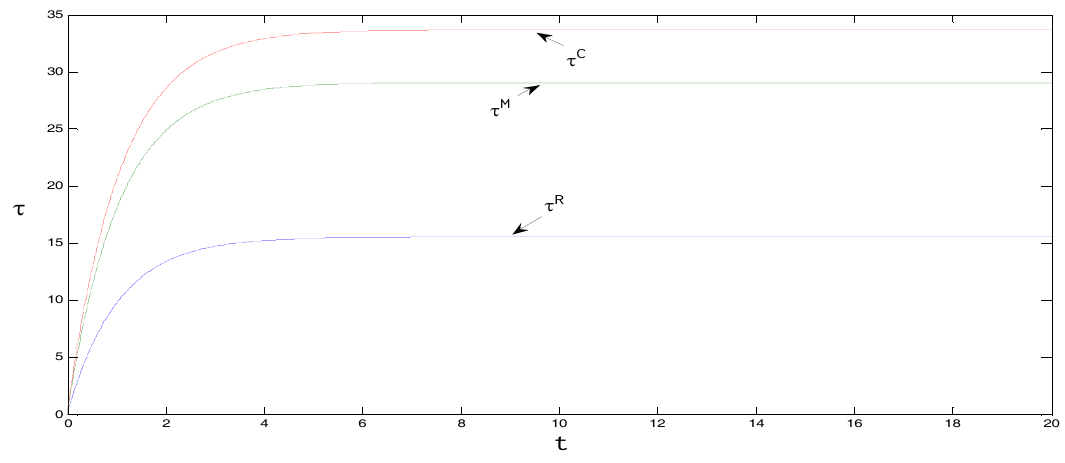
Figure 1. Comparison of carbon emissions reduction trajectories per product unit.